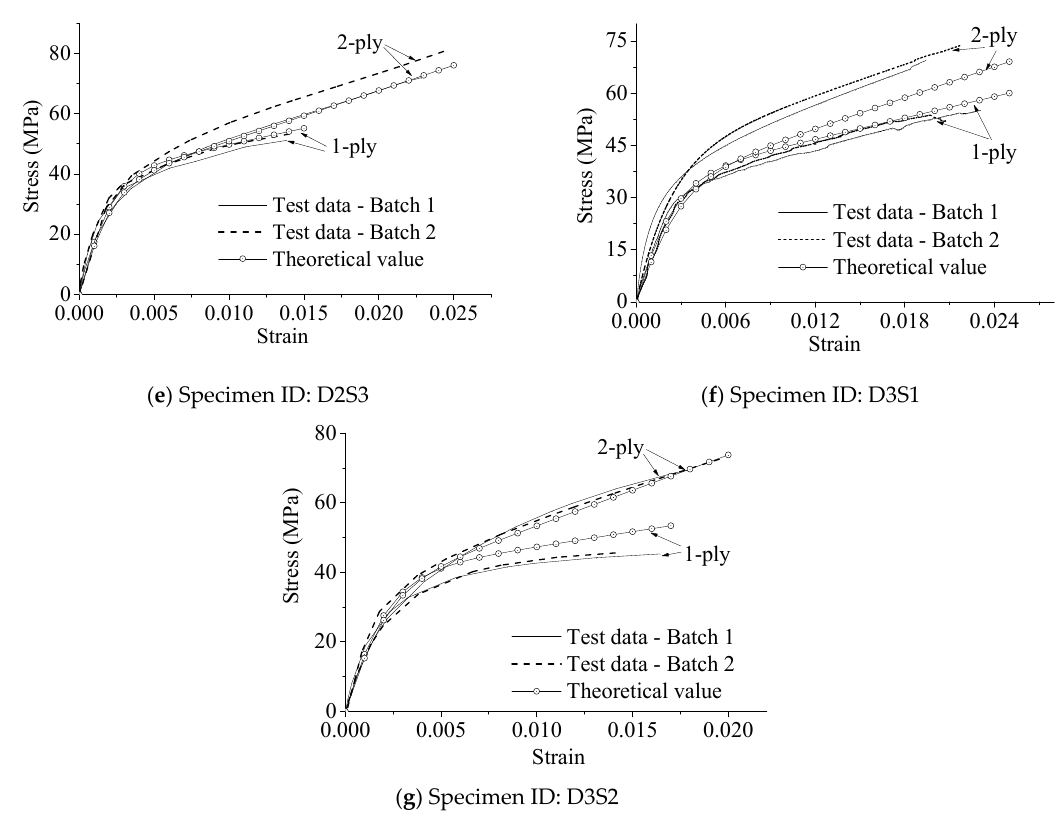
Figure 13. Performance of the proposed model.